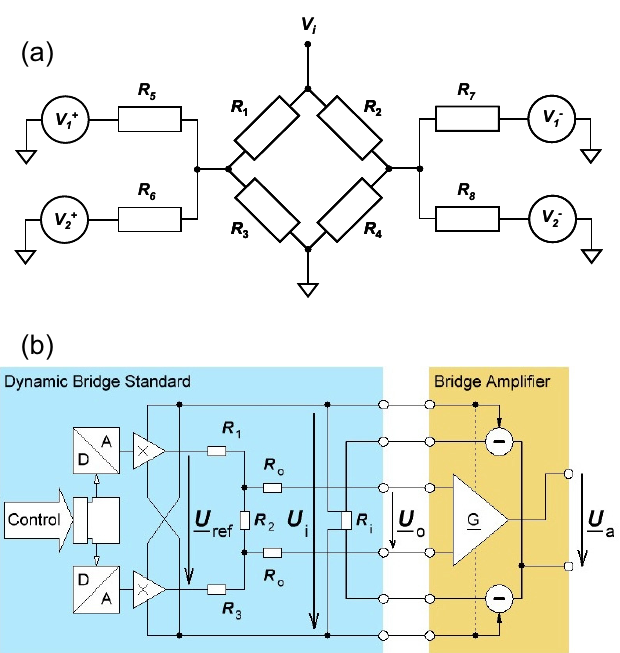
Fig. 14. Schematic of the strain gauge simulation in the NPL dynamic bridge standard (a) and operation principle of the PTB dynamic bridge standard